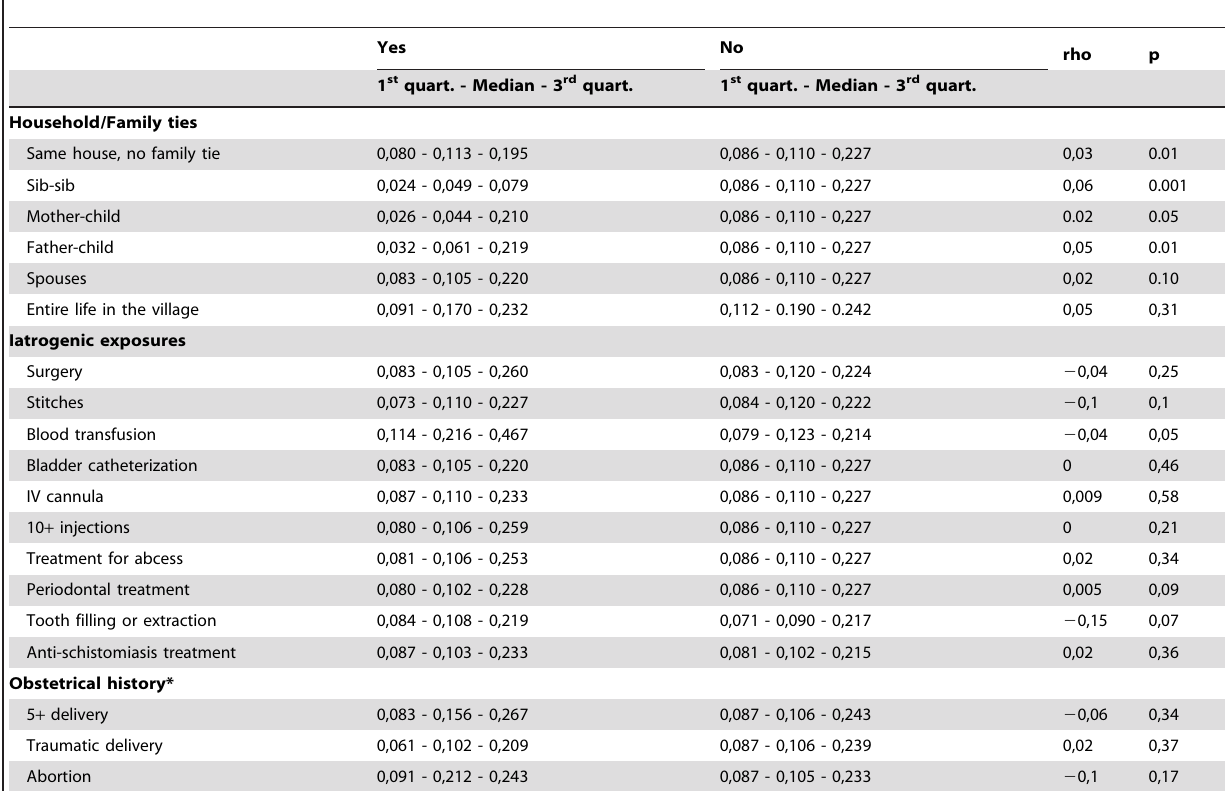
Table 3. Pairwise E1 HCV genetic distances among 66 subjects according to common exposure